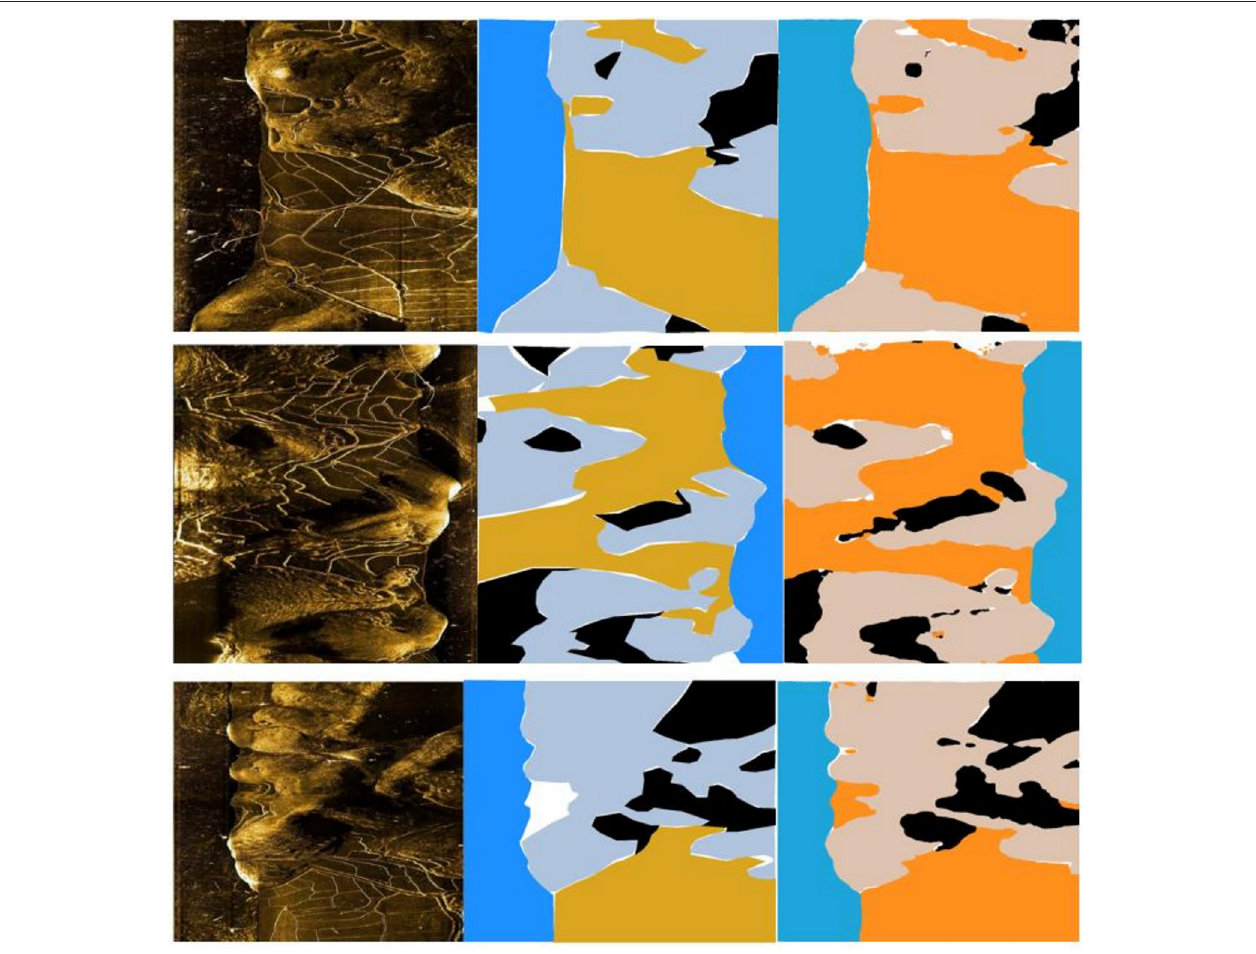
FIGURE 11 | The segmentation results are shown in the figure: from left to right are the original picture, marking and training results, respectively. The colors in the figure represent the results: blue represents water, gray represents rock, yellow represents land, black represents shadow, and white represents undifferentiated background.